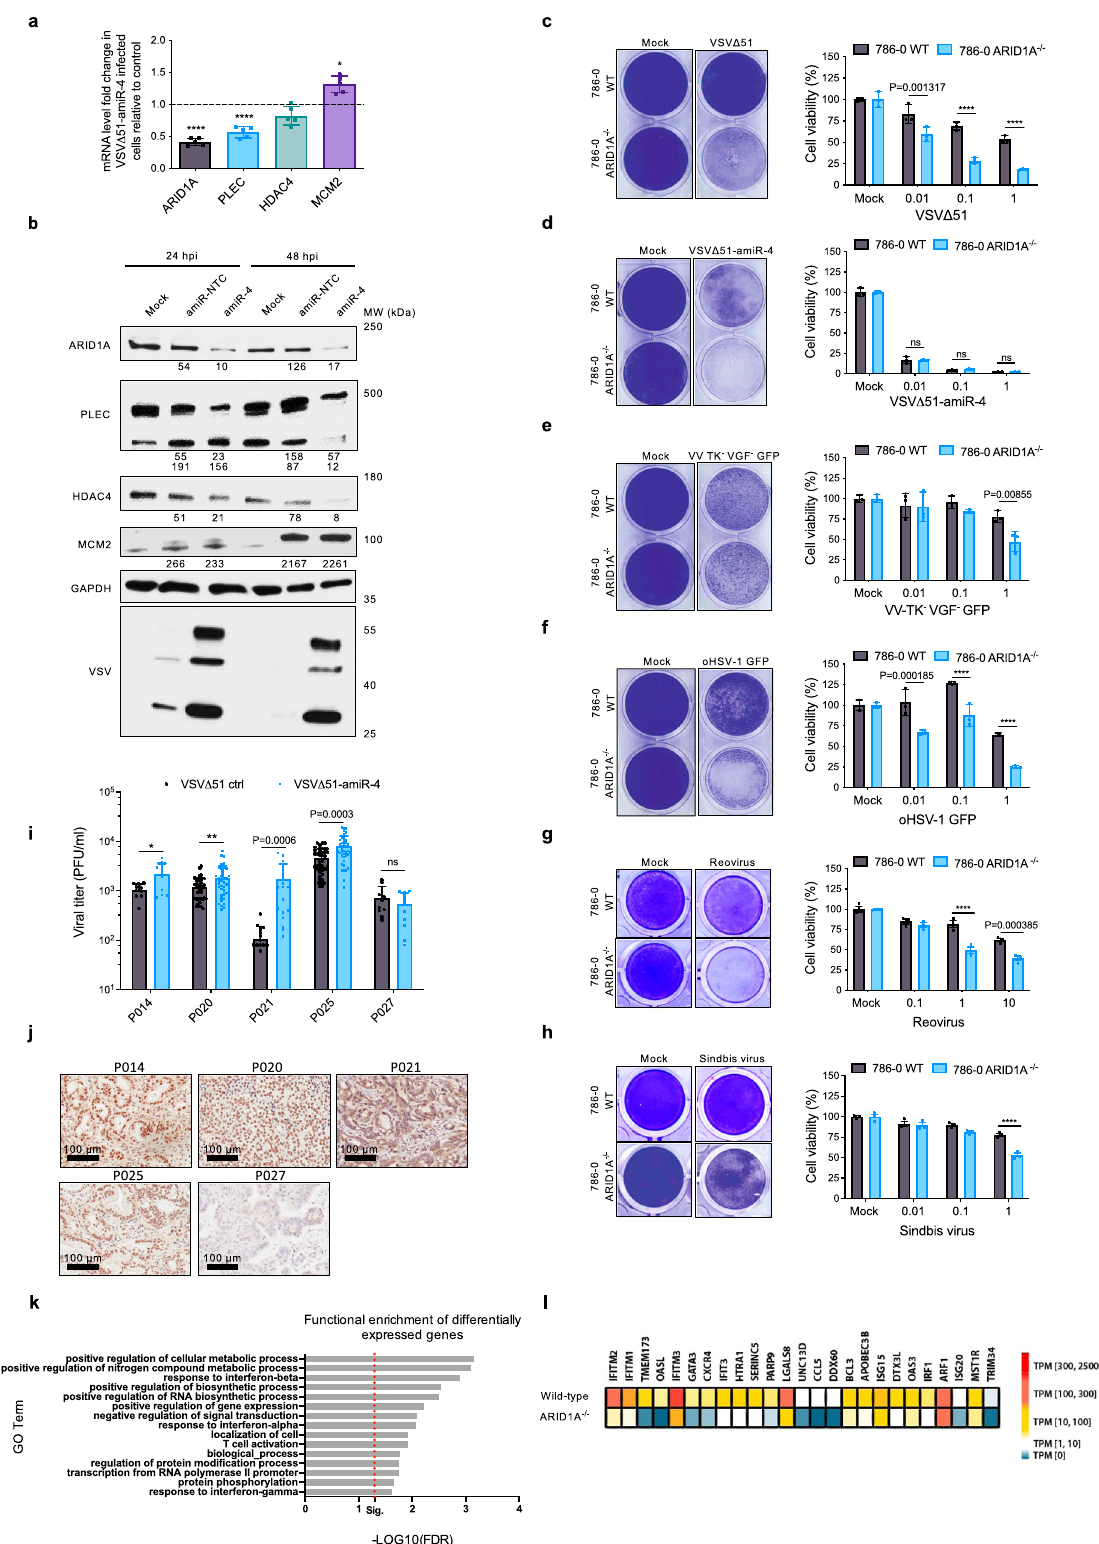
Oncolytic virus-mediated targeting of ARID1A creates a syn- thetic lethal phenotype . ARID1A represents a particularly interesting amiR-4 target since its deletion/mutation sensitises ovarian cancer cells to EZH2 methyltransferase inhibition with the small molecule GSK126 in a synthetic lethal fashion 24 . While synthetic lethality represents an attractive approach to